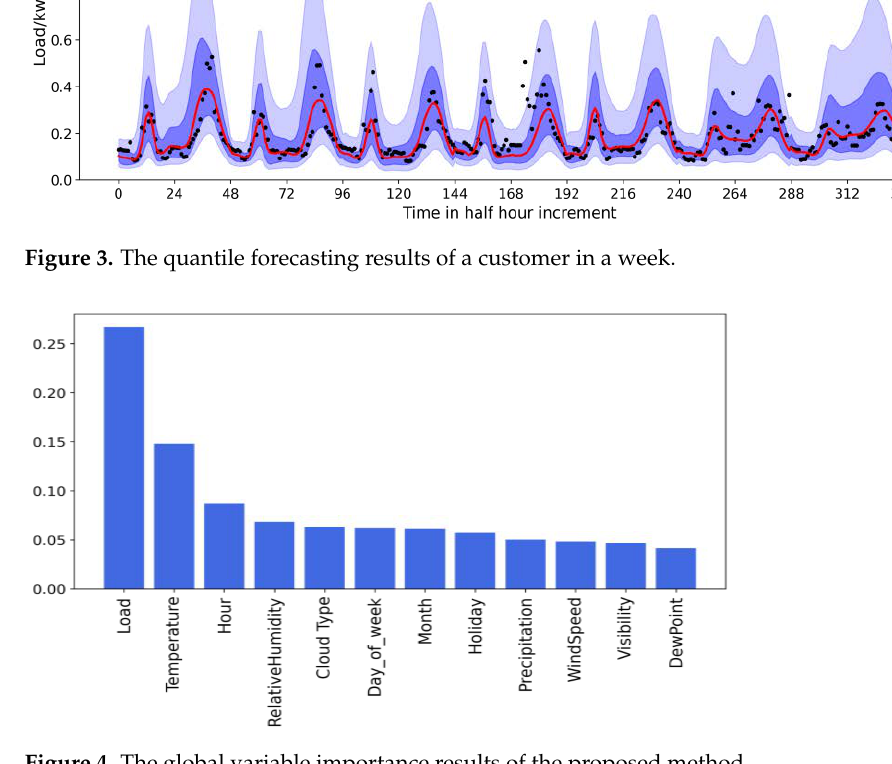
Figure 4. The global variable importance results of the proposed